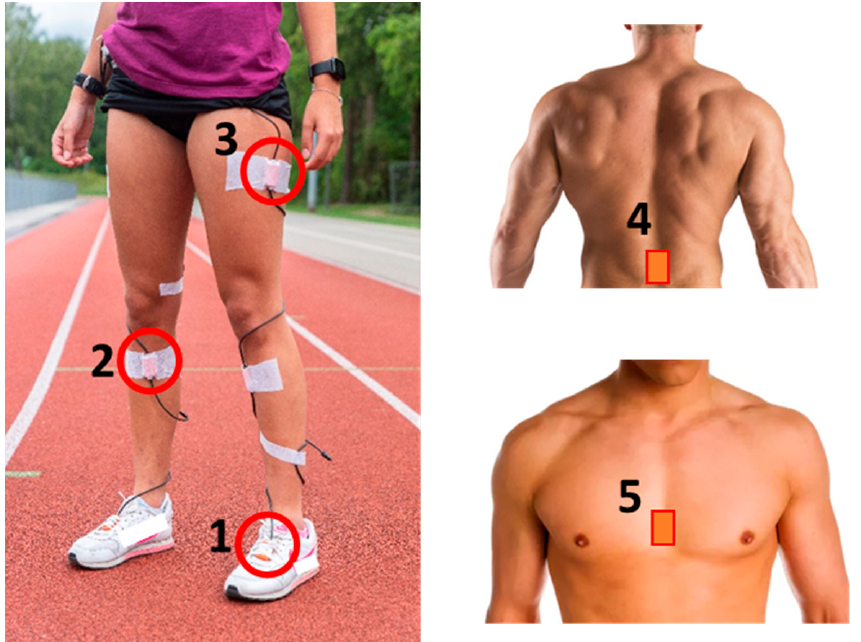
Figure 2. Measurement setup. IMUs are placed at both feet ( 1 , highlighted left foot), both tibias ( 2 , highlighted right tibia), both thighs ( 3 , highlighted left thigh), pelvis ( 4 ) and sternum ( 5 ).